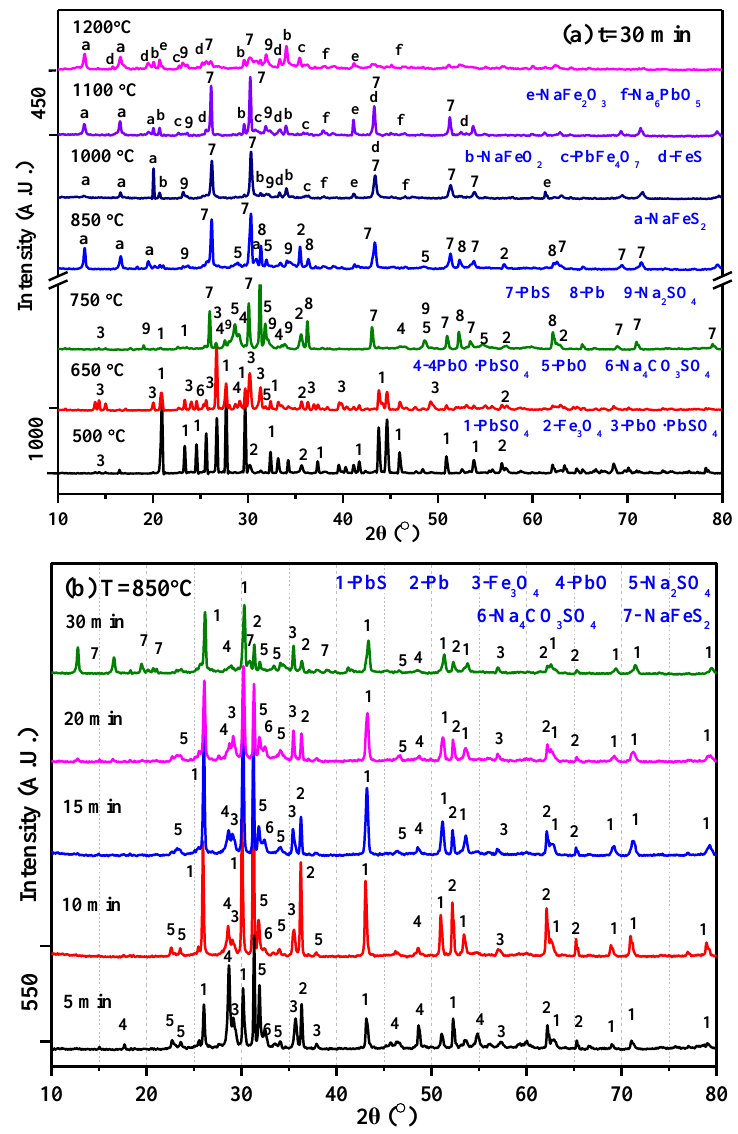
Figure 2. XRD pattern of the PbSO 4 -Na 2 CO 3 -Fe 3 O 4 -C mixture (molar ratio 3:3:1:18) at ( a ) different temperatures and ( b ) reaction times.